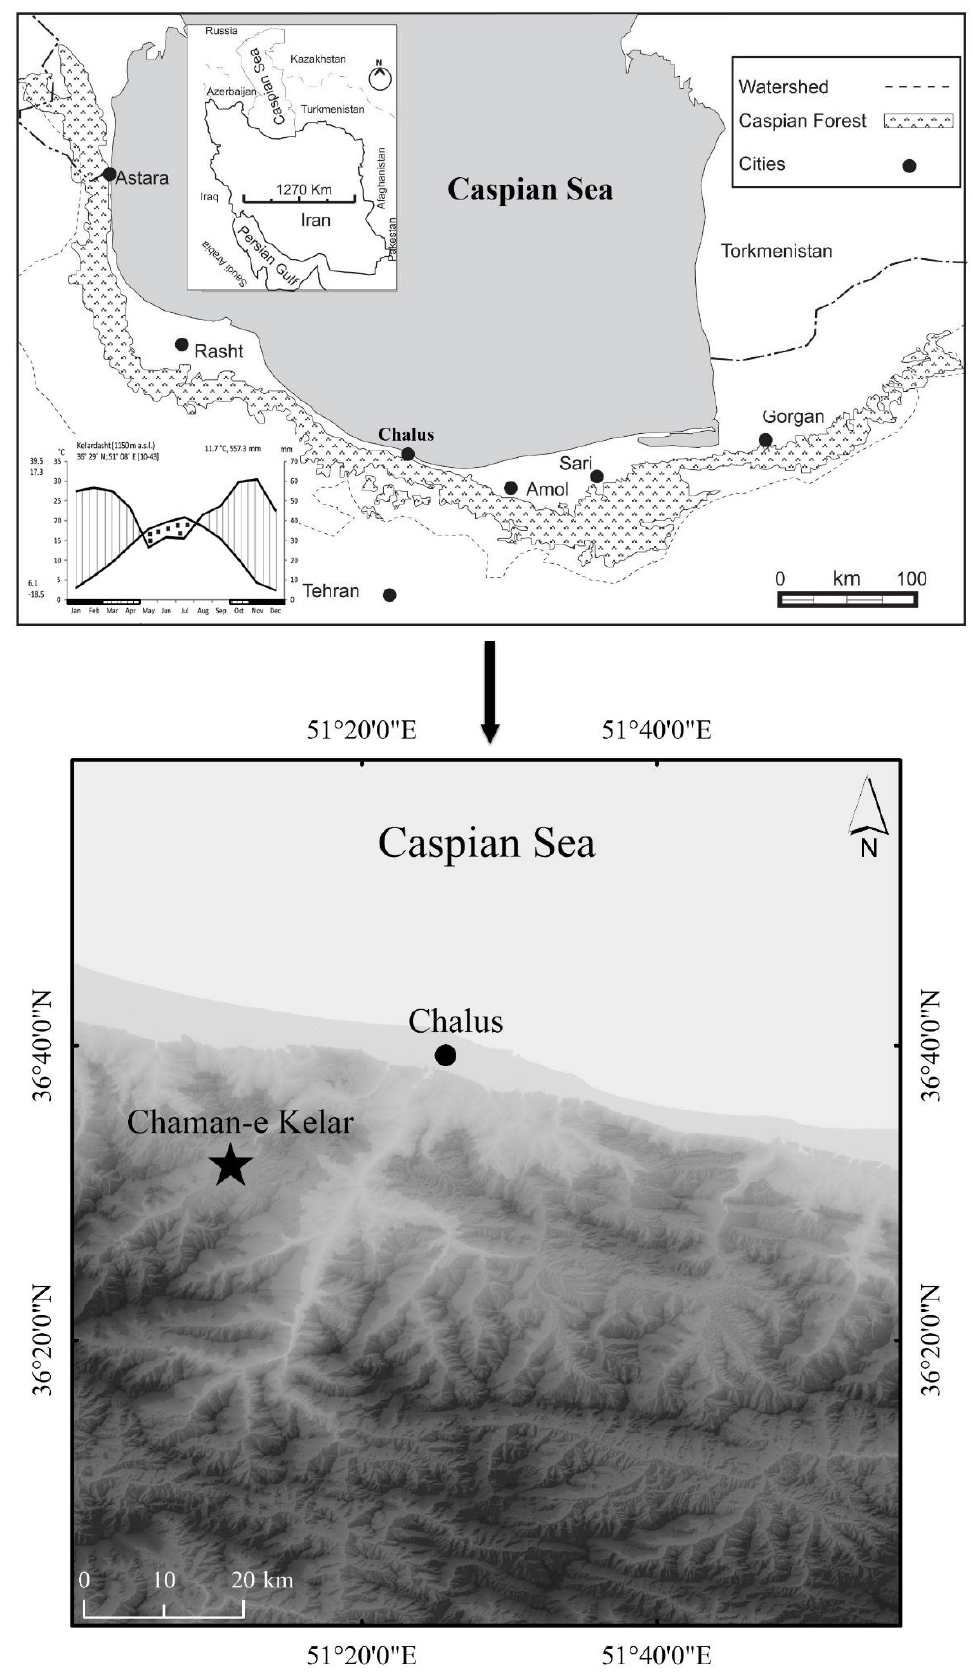
Figure 1. The location of the study area in Kelardasht, central Hyrcanian region, North Iran. Inset: climate diagram for the area